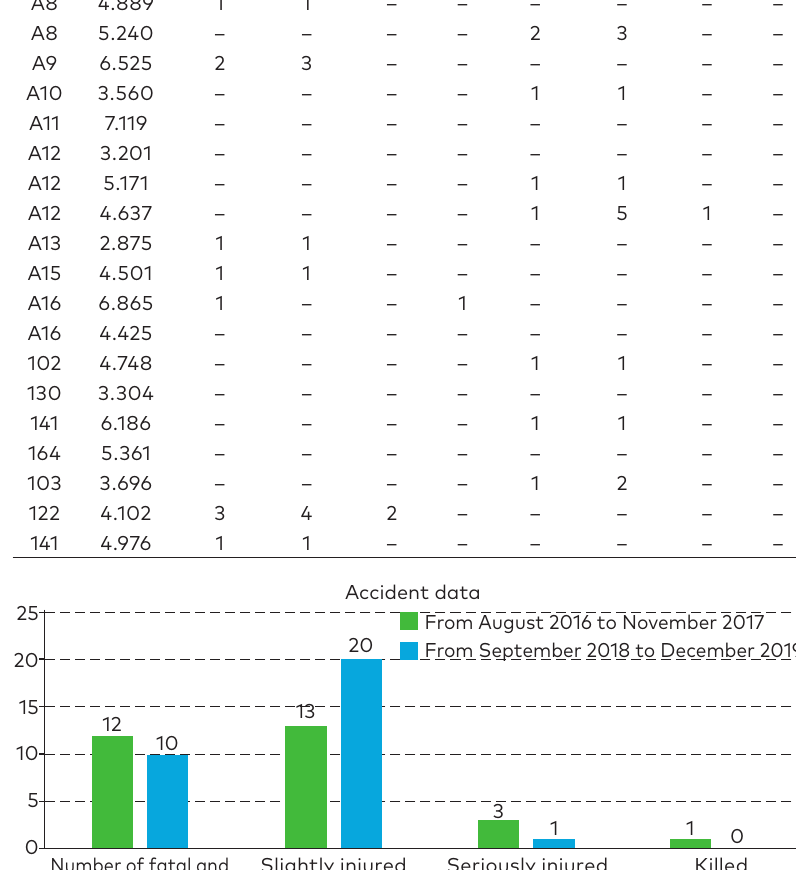
Figure 9. Comparison of accident data in the study periods